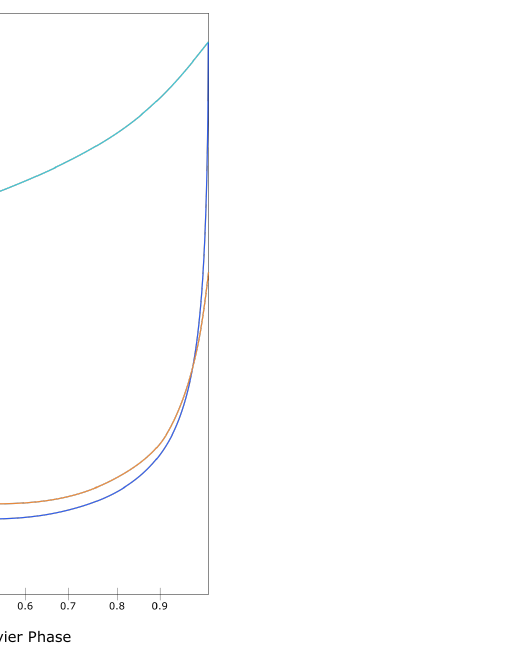
Figure 7. The relation between speed of sound and fraction of fluid mixture. Adapted from ref. [5]. The SoS can be measured by applying a line fitting algorithm [40,92] from an F-K plot of the DAS data, depicted in Figure 8. It is based on the slopes of the lines in the F-K domain, where the frequency and the high Fourier coefficients form the speed of sound [34]. It is formulated in Equation (2) where c m denotes the multiphase SoS, while λ , f , and k denote wavelength, frequency, and wavenumber respectively. It will be recalled that c m from the slope lines are consisted of the upgoing ( c u ) and downgoing ( c d ) SoS from the propagating acoustic wave. The positive slope of the line represents the c u , while the negative one represents the c d .